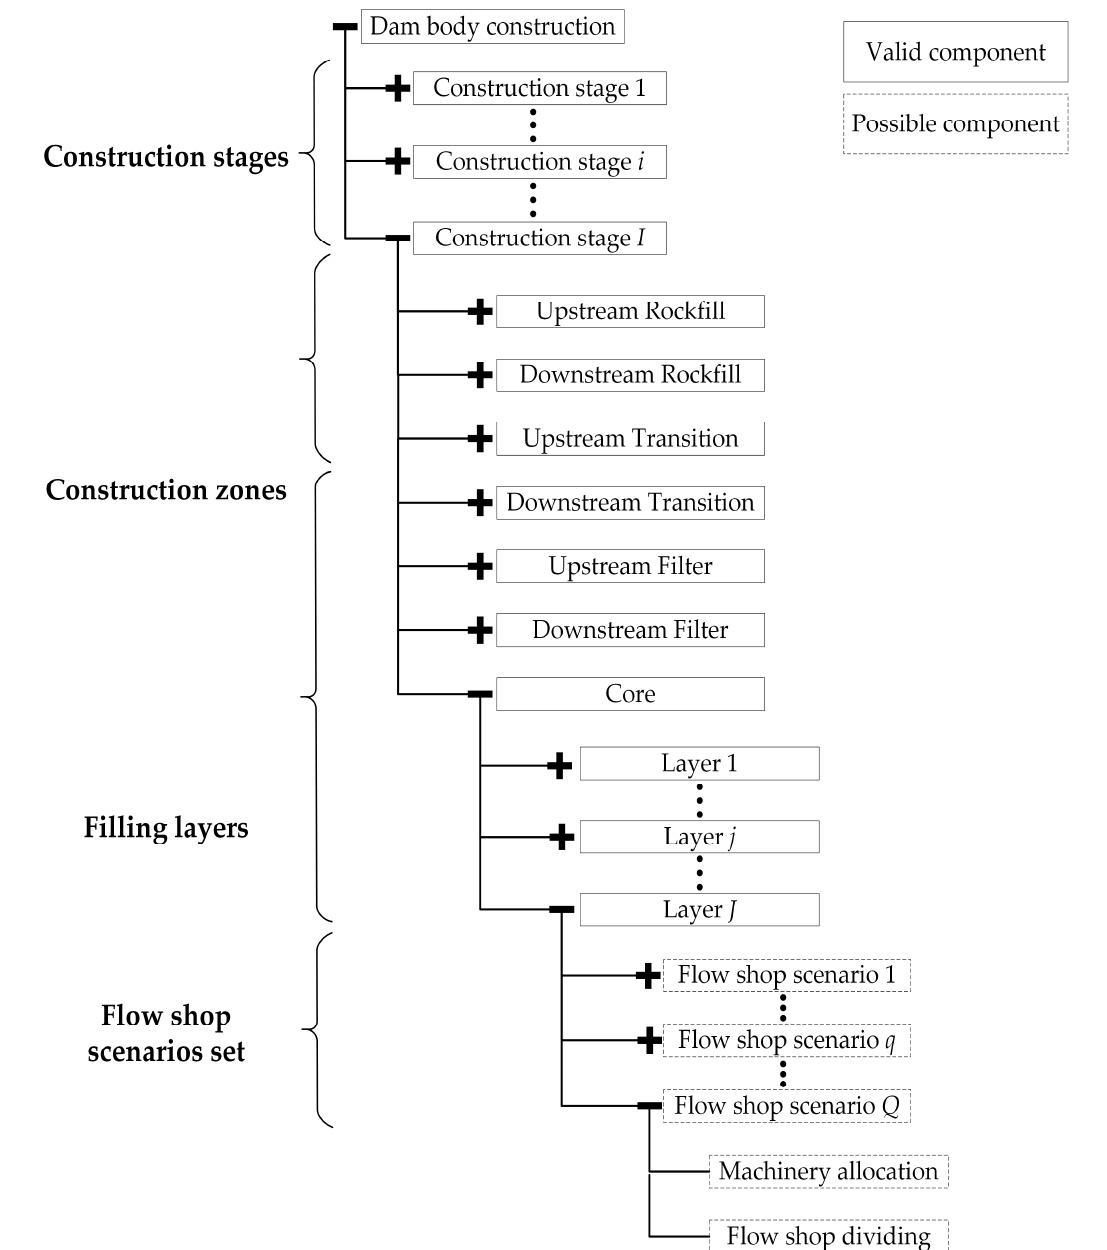
Figure 1. Work breakdown structure (WBS) of high core rockfill dam construction.